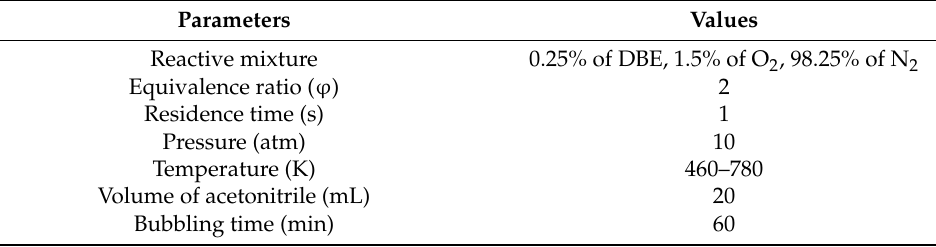
Table 1. Experimental conditions for the DBE oxidation in a